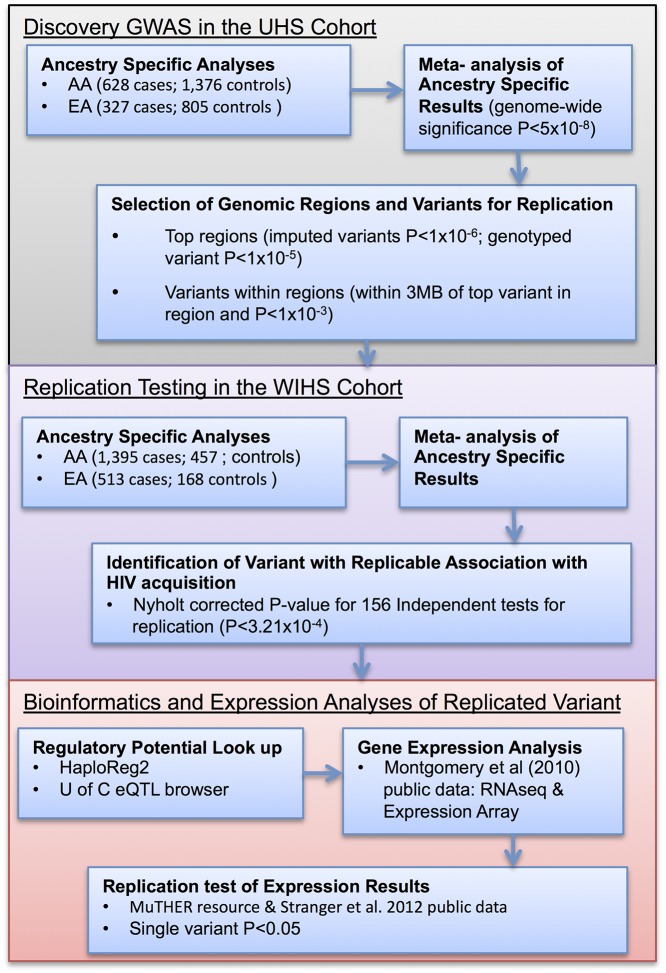
Overview of Study Design.AA represents African Americans, EA represents European Americans, and UofC represents University of Chicago.